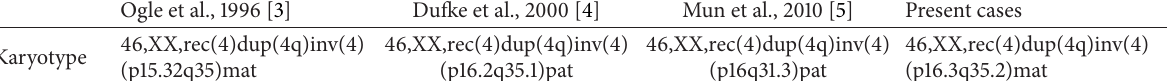
Table 1: Karyotype and phenotype comparison among cases with recombinant chromosome 4. Ogle et al., 1996